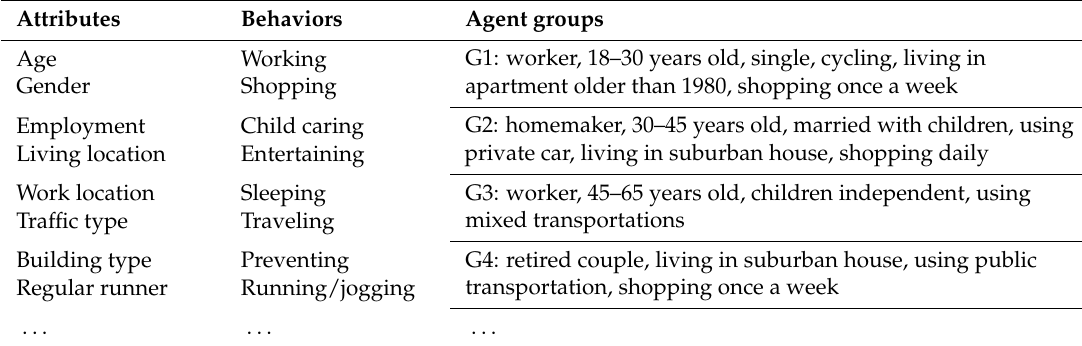
Table 2. Example of agents’ attributes, behaviors, and agent groups with different daily activities (no relation between the columns).